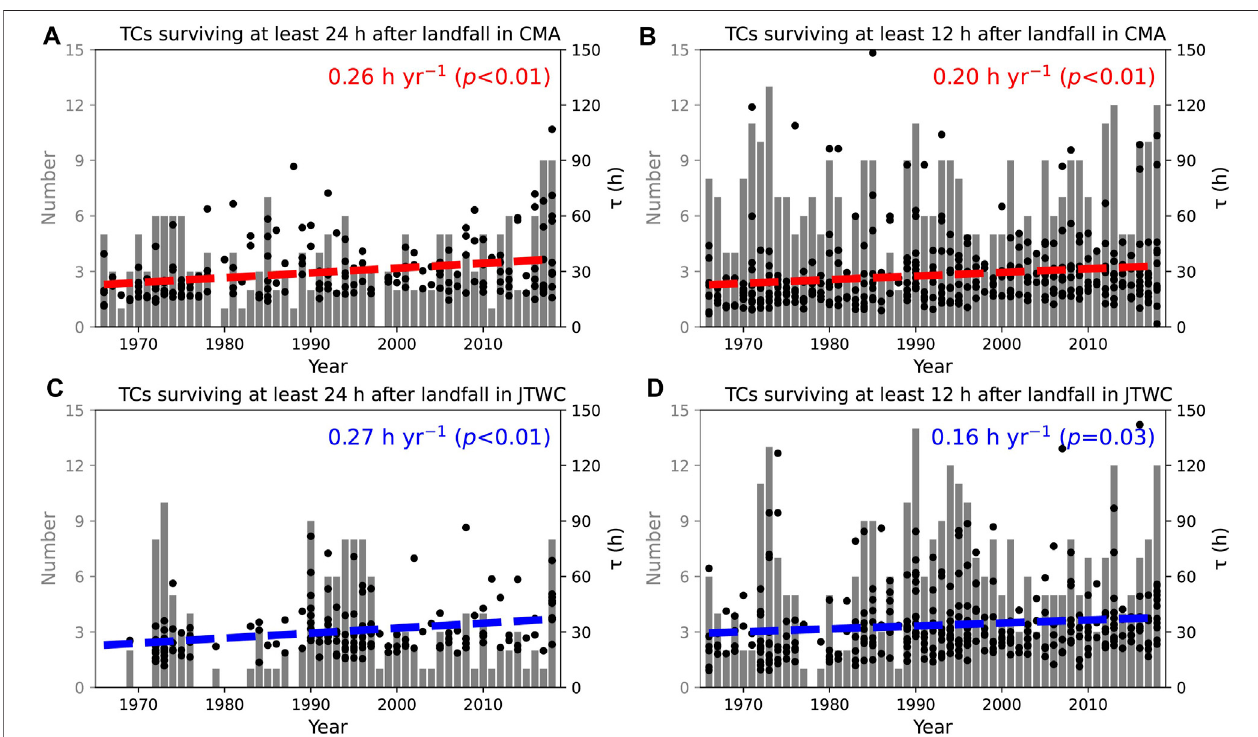
FIGURE4| Timeseriesoftheannualnumber(graybars)andthedecaytimescale τ (points)for (A) 24-hlandfallsinCMA, (B) 12-hlandfallsinCMA, (C) 24-hlandfalls in JTWC and (D) 12-h landfalls in JTWC during the period from 1966 – 2018. The dashed lines denote the long-term trends obtained by least squares, while their corresponding slopes and signi fi cance levels are given in the